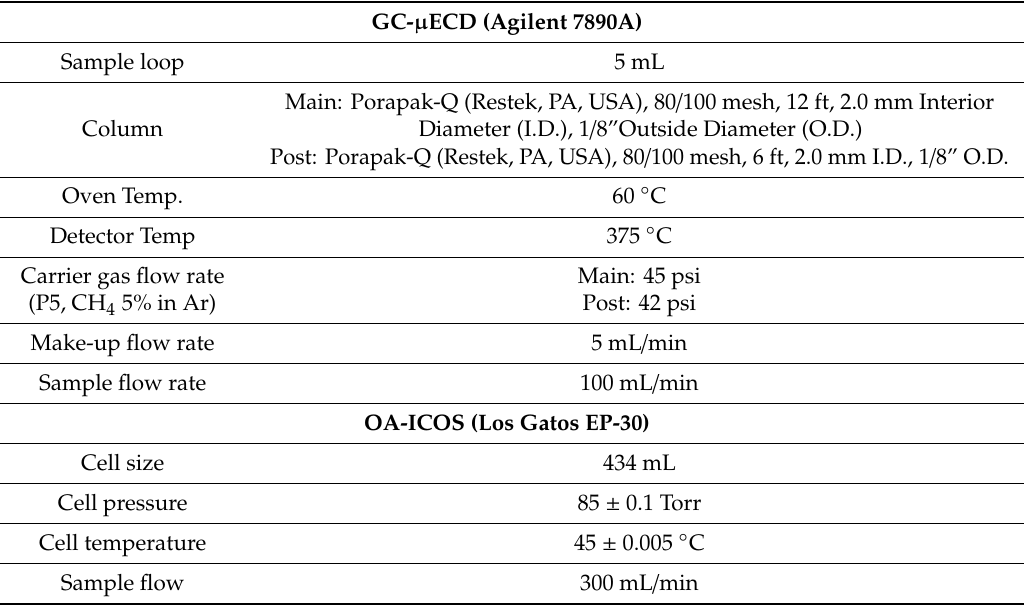
Table 1. The analytical conditions for the microelectron capture detector method (GC- µ ECD) and the performance specification for off-axis integrated cavity output spectroscopy (OA-ICOS).